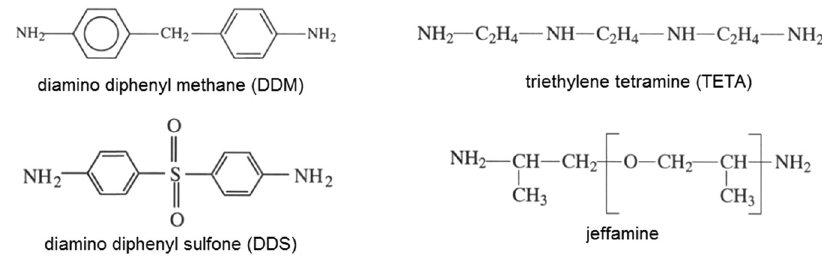
Figure 6: Chemical structure of several curing agents of amines [ 32 ]